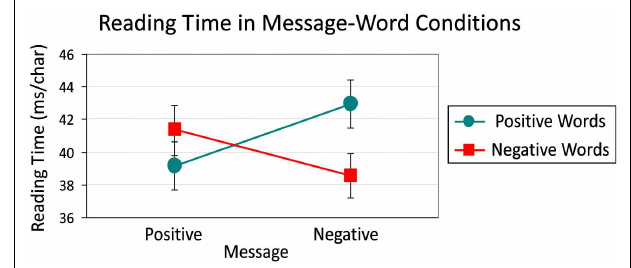
FIGURE 1 | Reading time (ms/char) with standard error bars across Message × Word conditions.